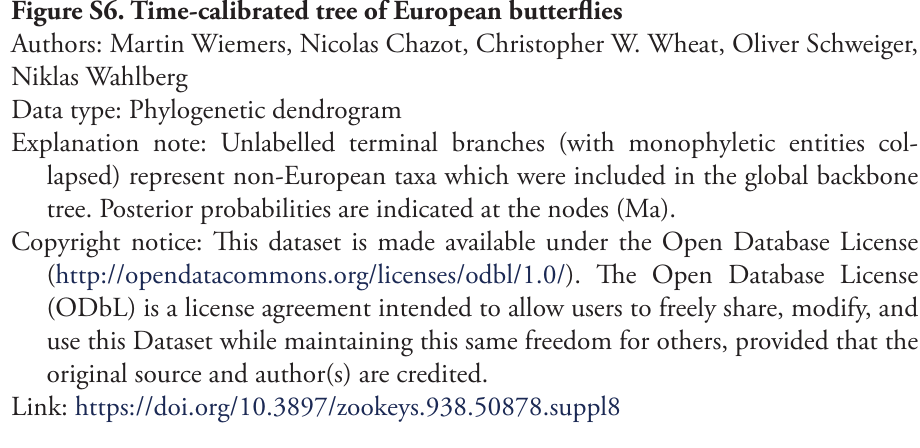
Figure S6. Time-calibrated tree of European